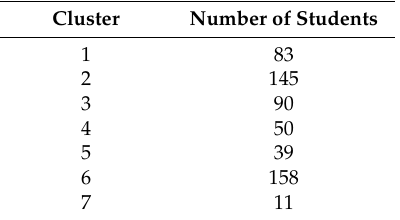
Table 12. Number of students associated with each cluster.